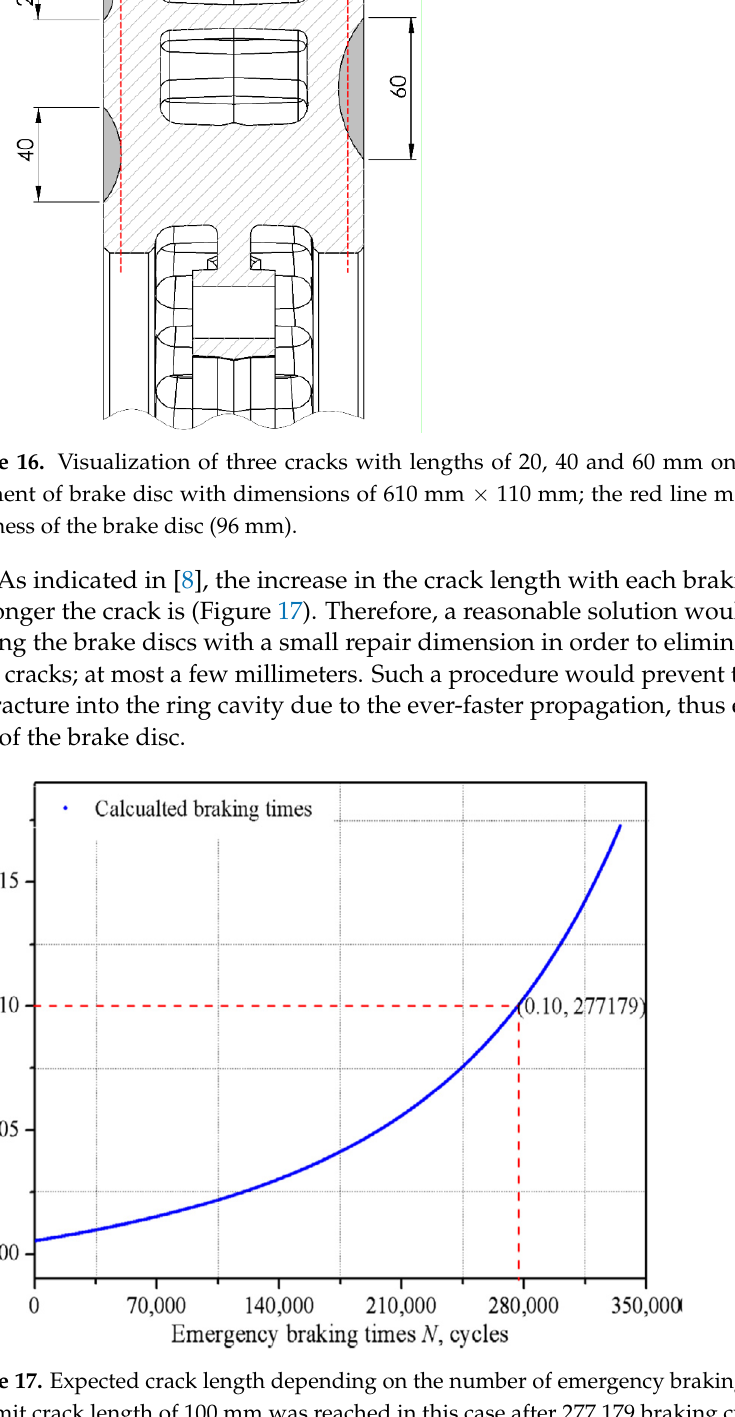
14 of 18 Figure 15. The dependence of the depth of the crack on its length; blue—depths determined from the regressive functions of circles, red—linear dependence of the crack depth on its length. The designated regression functions for estimating the depth of the crack give high coefficients of determination R 2 at the level of 0.95–0.97, which proves that the model is well-adjusted to the measurement results. Thus, it can be concluded that the depth of surface cracks, up to 70 mm long, on cast iron brake discs can be determined by simply measuring their lengths. 6. Discussion